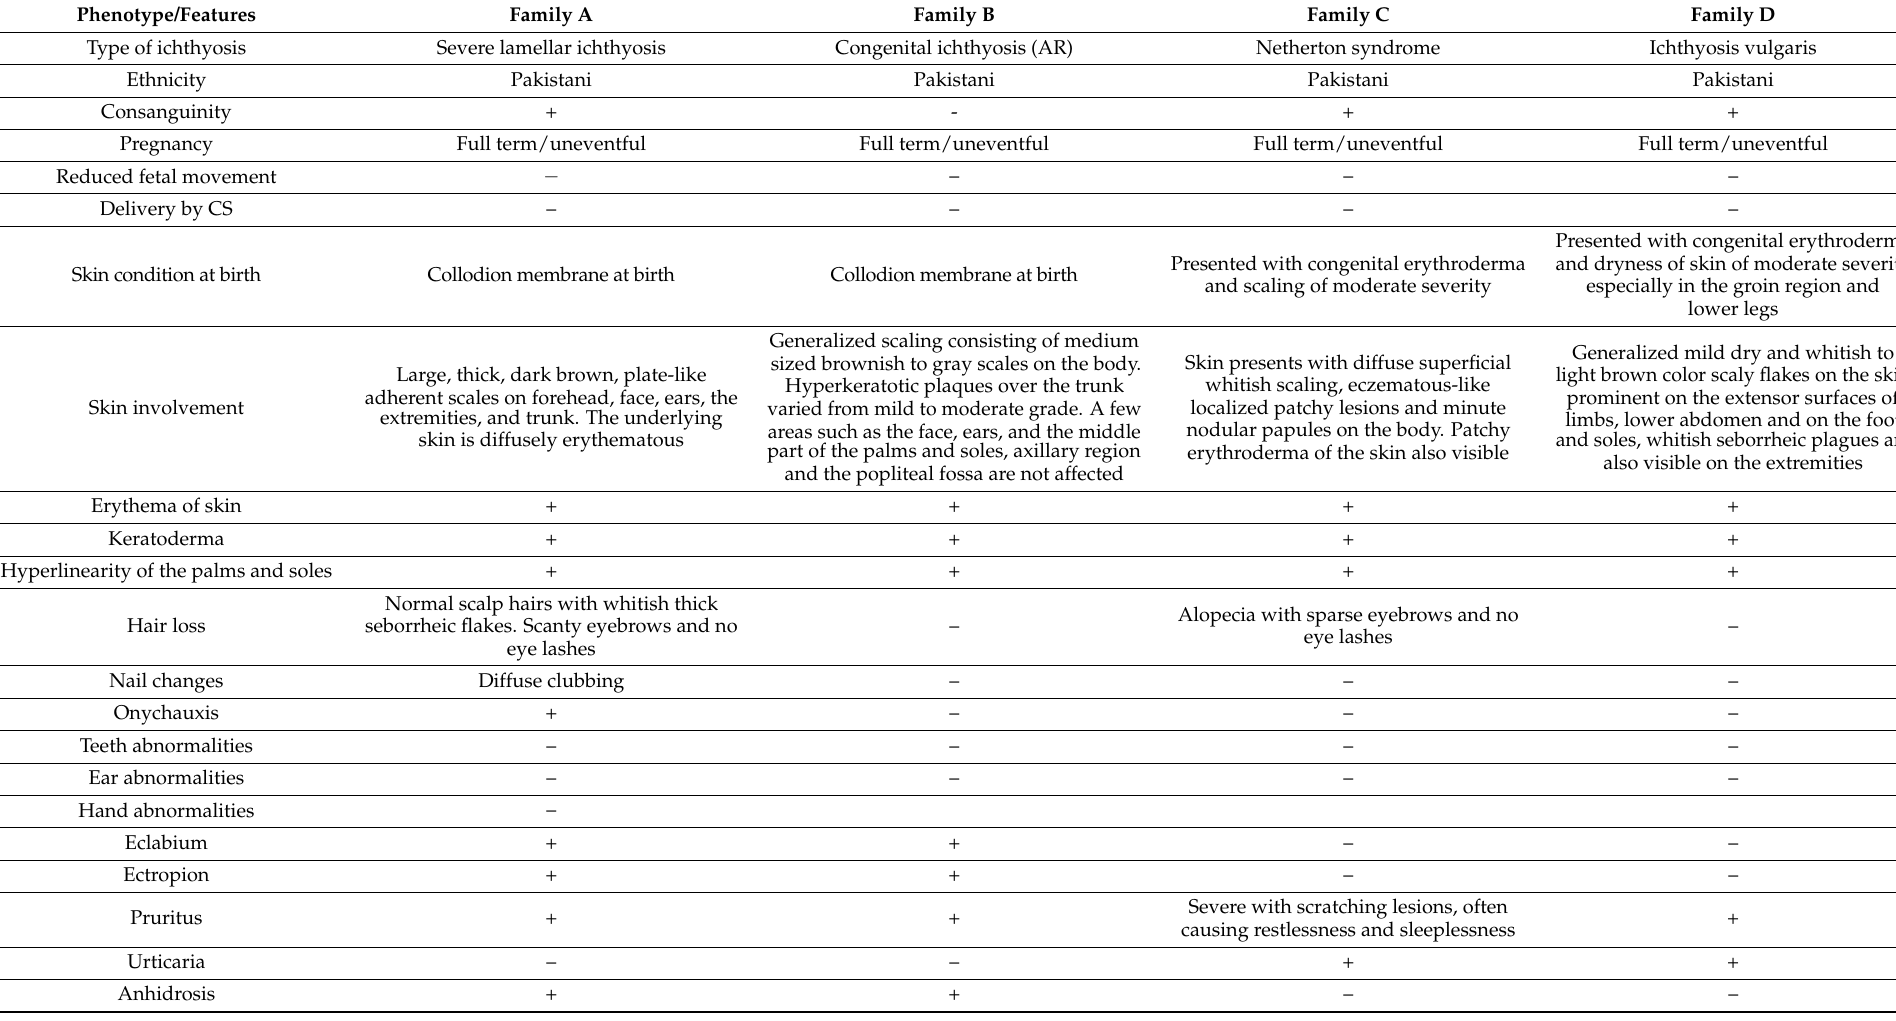
Table 1. Clinical phenotypes of the patients in four Pakistani ichthyosis